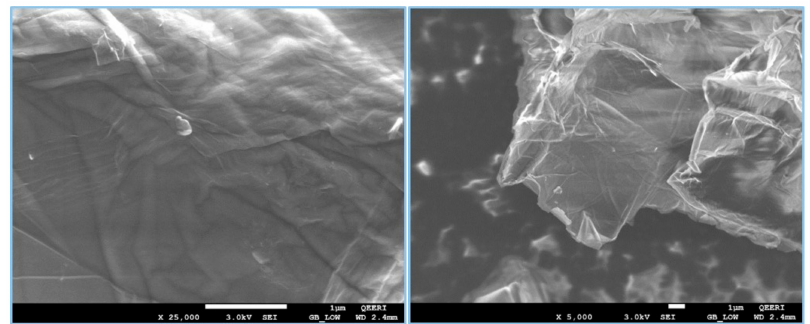
Figure 1. SEM images of GO showing the sheet-like morphology.